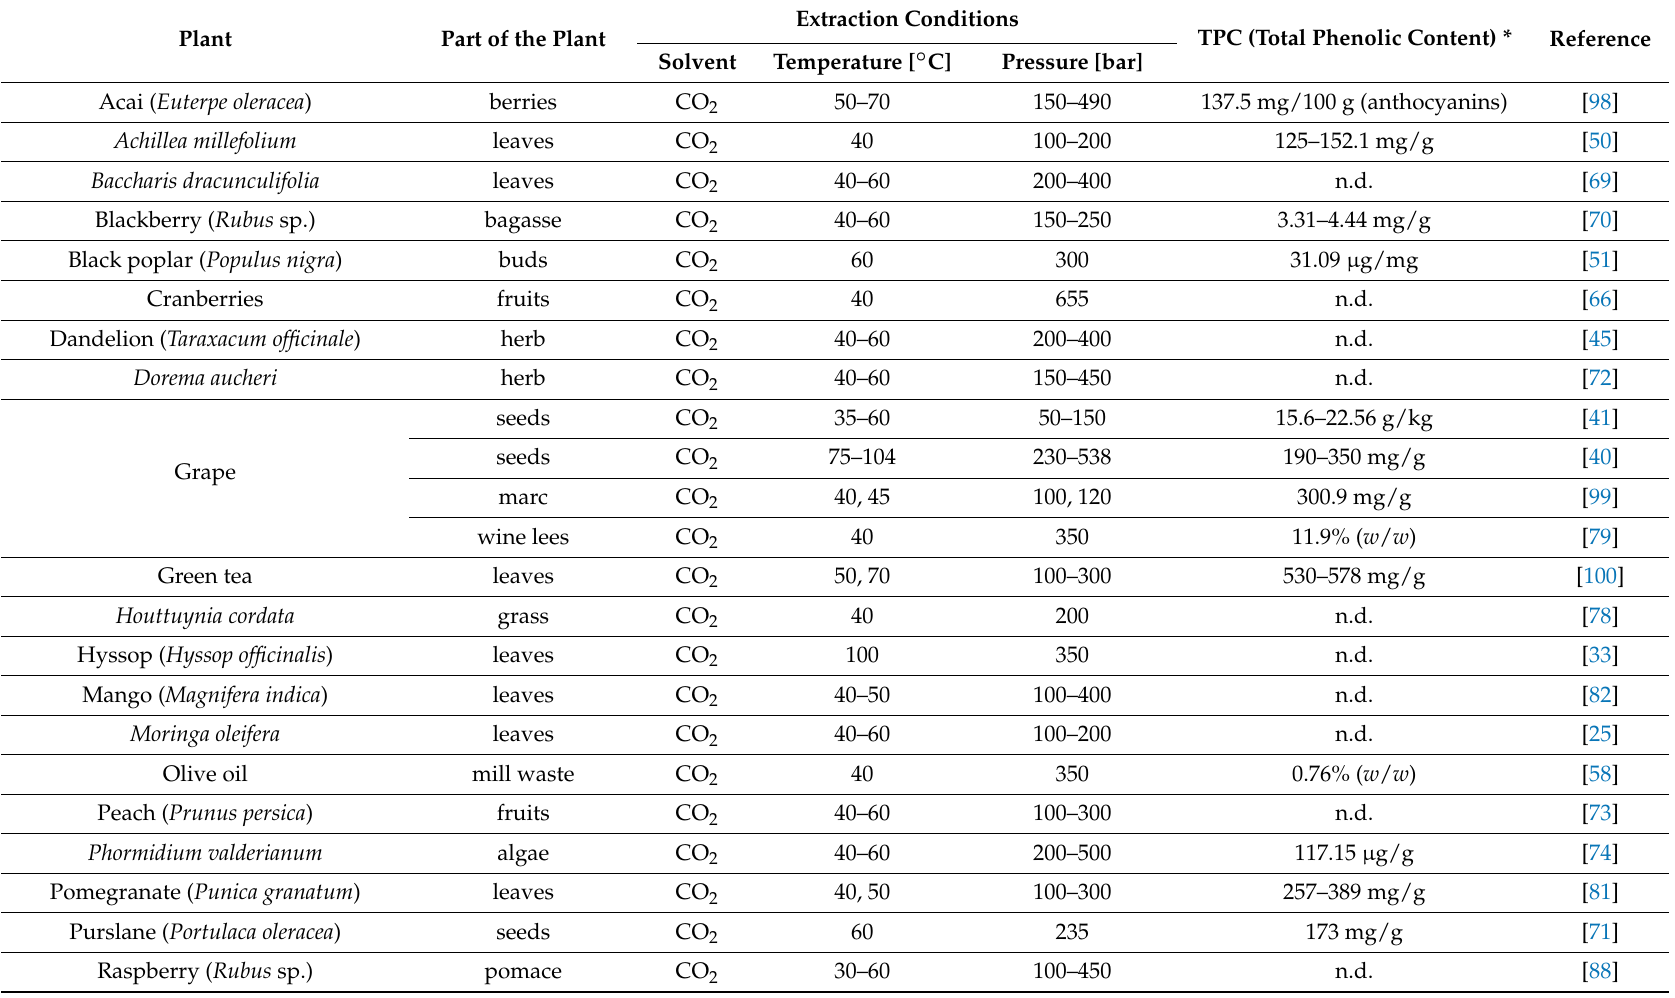
Table 1. Applications of pure CO 2 in phenolic compounds